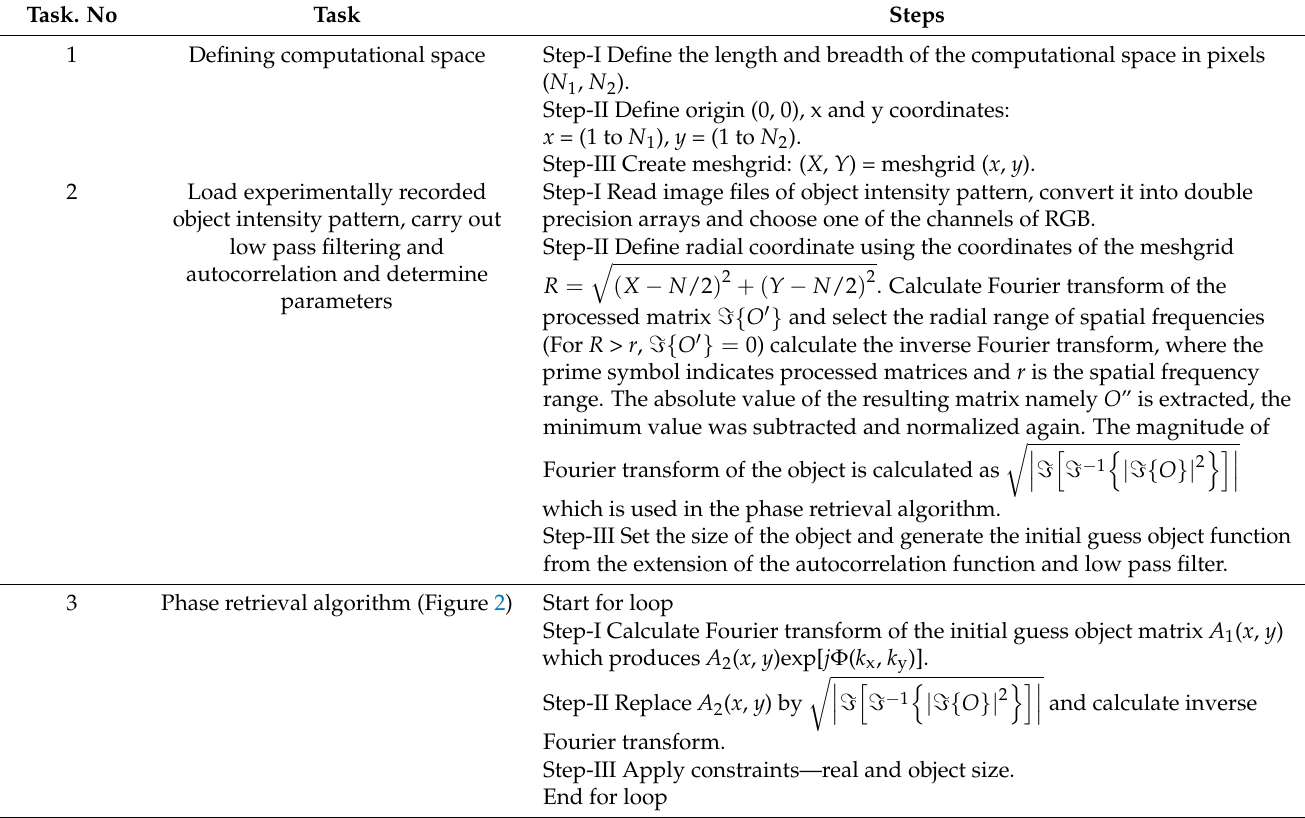
Table 2. Pseudocode for the reconstruction of the image for non-invasive mode of imaging through occlusion. Task.